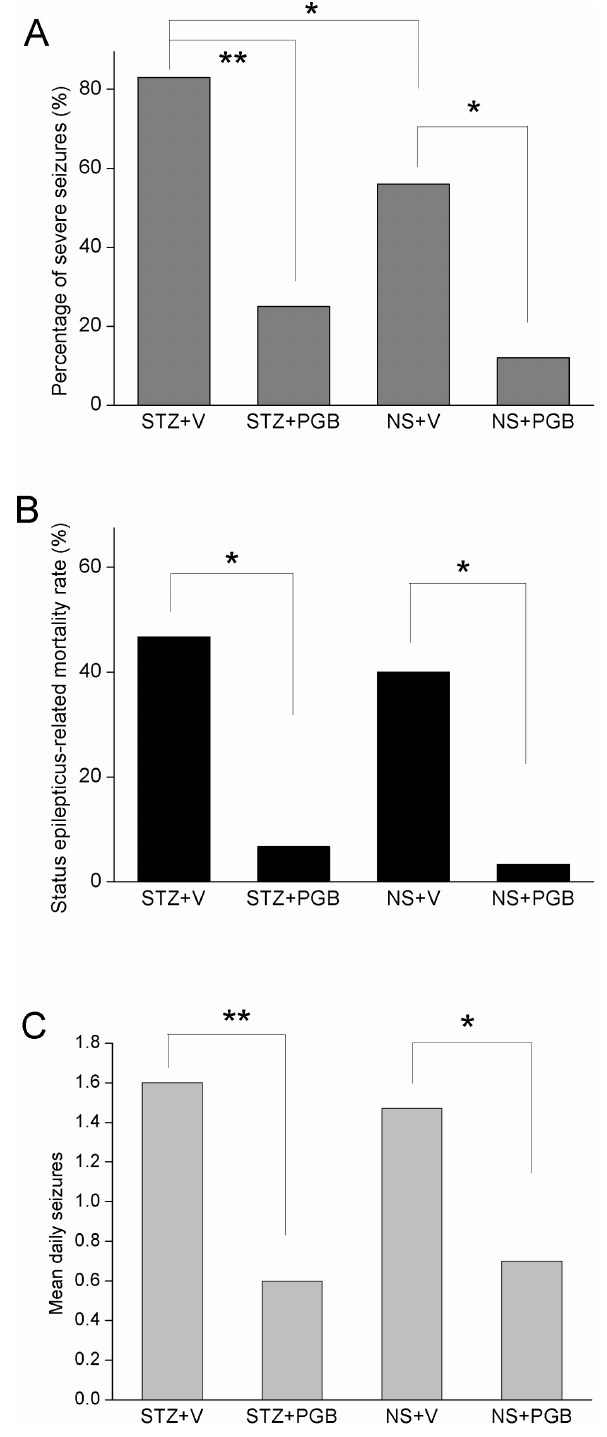
Figure 2. Pilocarpine-induced seizures in the streptozotocin (STZ)-induced diabetes and normal saline (NS) groups. A: The STZ + PGB (pregabalin) group had a significantly lower percentage of severe seizures (stages 3–5) than did the STZ + V (vehicle) group ( p , 0.01). Similarly, the NS + PGB group had a lower percentage of severe seizures than the NS + V group did ( p , 0.05). B: Status epilepticus-related mortality was significantly higher in the STZ + V group than in the STZ + PGB group ( p , 0.05, n=30 in each group), and was significantly higher in the NS + V group than in the NS + PGB group ( p , 0.05, n=30 in